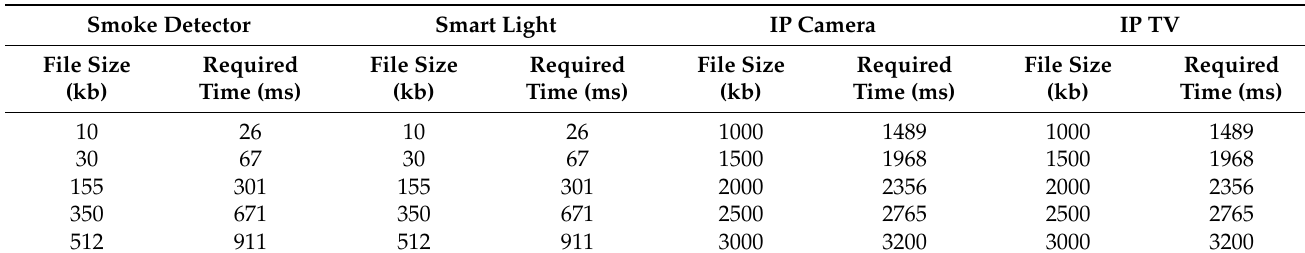
Table 3. Required time for key generation using the proposed method. File sizes are shown in kilobit (kb) and required time is shown in millisecond (ms). For the smoke detector and smart light, the same file sizes are used, while the same file sizes are used for the IP Camera and IP TV.